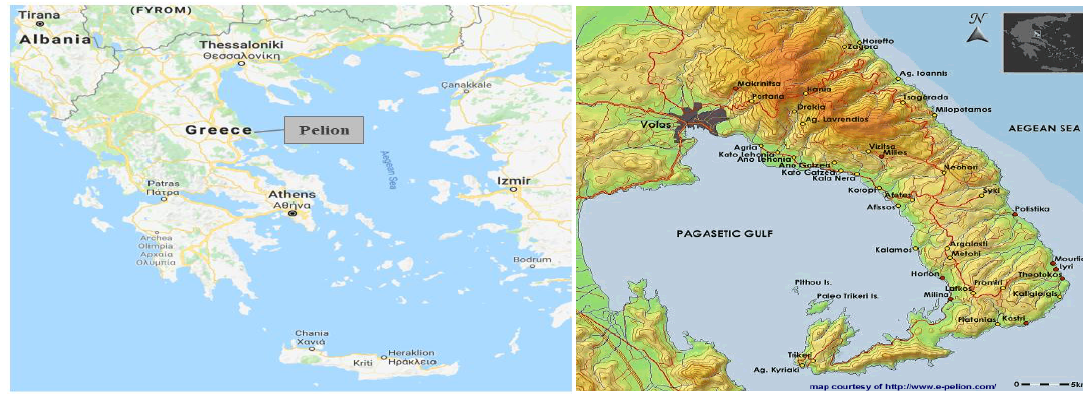
Figure 1. Field research placement.